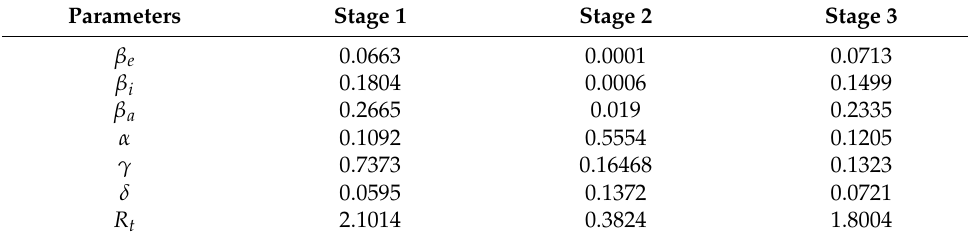
Figure 3. Application of the model with Japanese data. The duration of COVID-19 infection is separated into three stages. Stage 1 is the initial transmission period. Stage 2 is the period with highly restrictive measures in the state of emergency. Stage 3 is the period when the state of emergency is lifted. ( a ) Fitting of the cumulative infected cases. ( b ) Fitting of the daily infected cases. The red dots represent the real data points. The blue areas represent the confidential interval simulated by the model. Table 1. Model parameters by